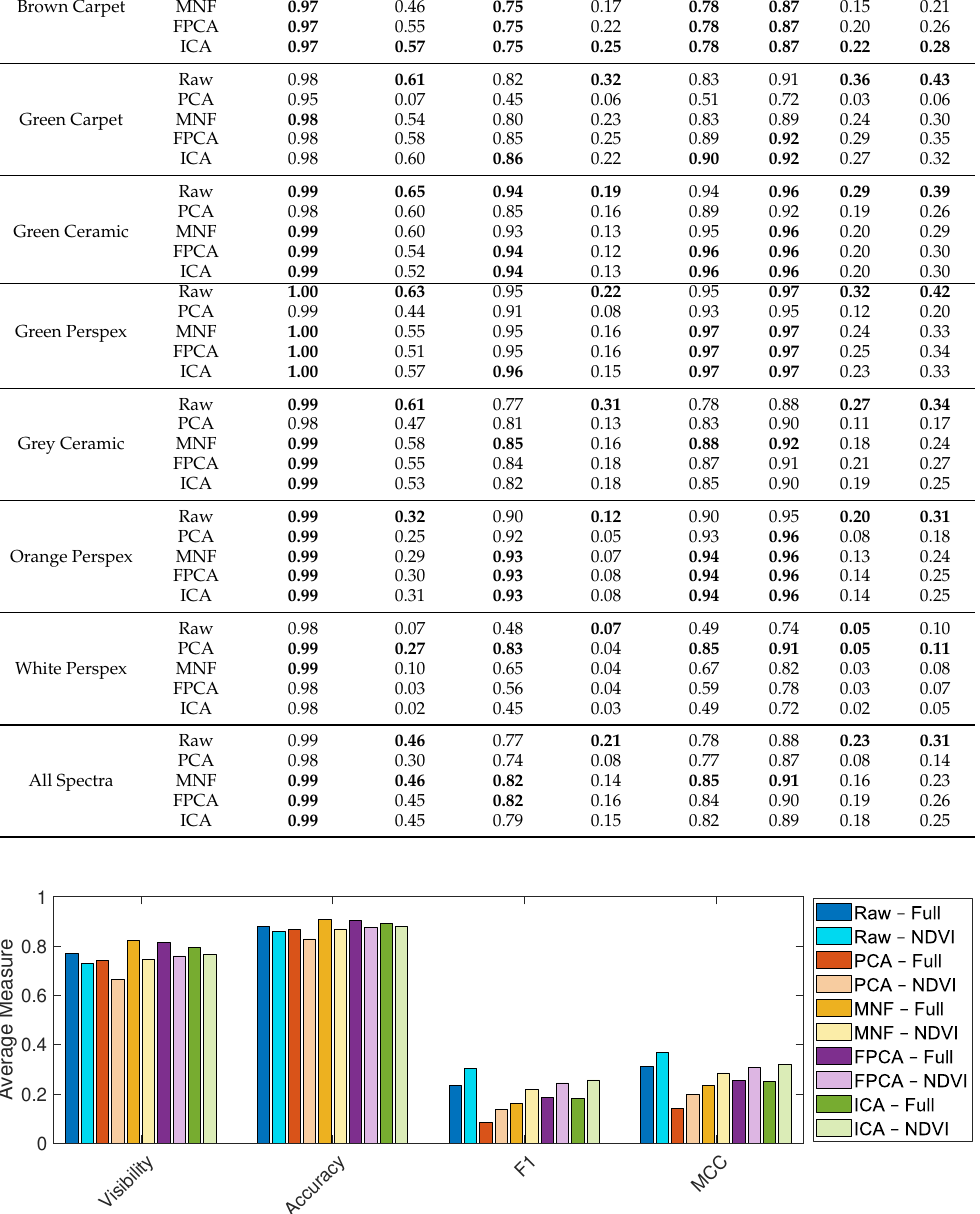
Figure 18. Comparison between the performance measures when combining spatial and spectral DR on the Selene